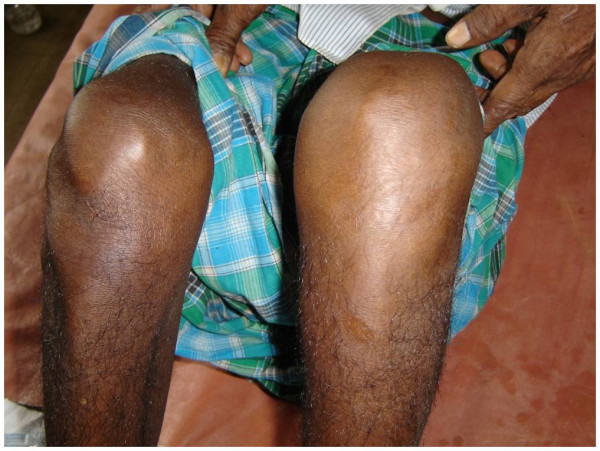
Left knee swelling.